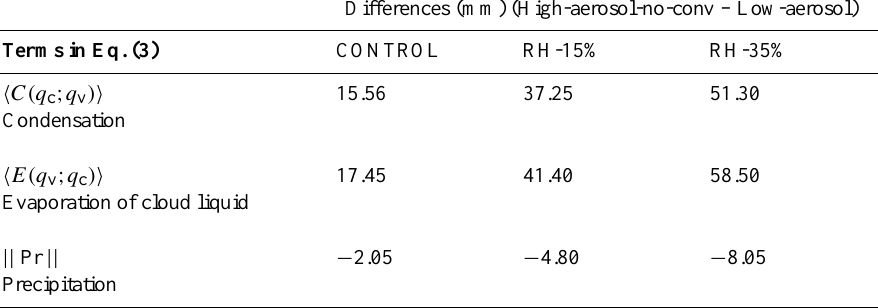
Table 4. Domain-averaged differences in the accumulated sources and sinks of precipitation, retained in the approximated Eq. (3) between the high-aerosol-no-conv and low-aerosol